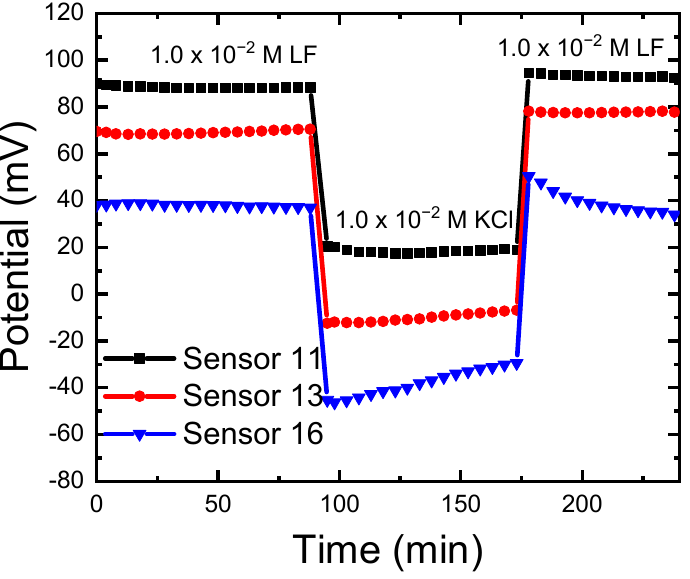
Figure 7. Morf inner water layer test for carbon paste electrode (CPE, sensor 11); PVC membrane coated on carbon paste electrode (C-CPE, sensor 13); PVC/CD plasticized carbon paste electrode (P-CPE, sensor 16). Potentials of the electrodes were recorded in a solution containing the primary ion (1.0 × 10 − 2 M LF) for one hour, then in a solution containing an interfering ion (1.0 × 10 − 2 M KCl) for one hour, and then changing back to the LF solution again. The electrode compositions (%, wt / wt ) are given in (Table 1). All measurements at pH 4.1 using acetate buffer at room temperature of 22 ± 2 ◦ C. Table 2. Effect of the pH on the response characteristics of the optimized sensors.